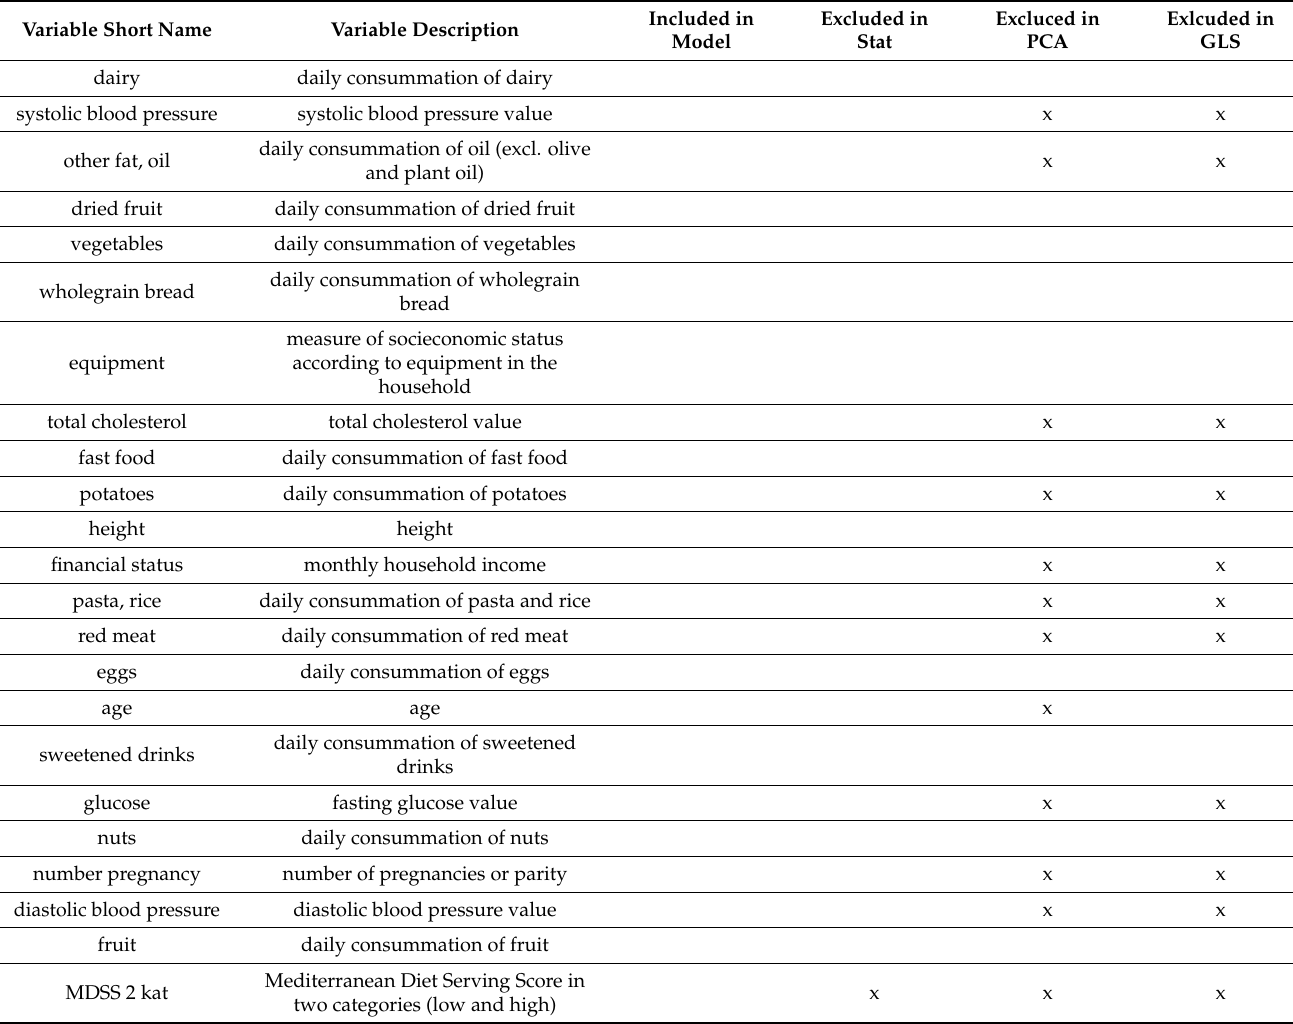
Table A1. A list of variables per